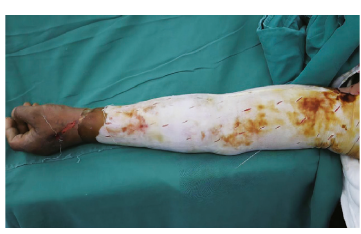
Figure 2: 3d after treatment.